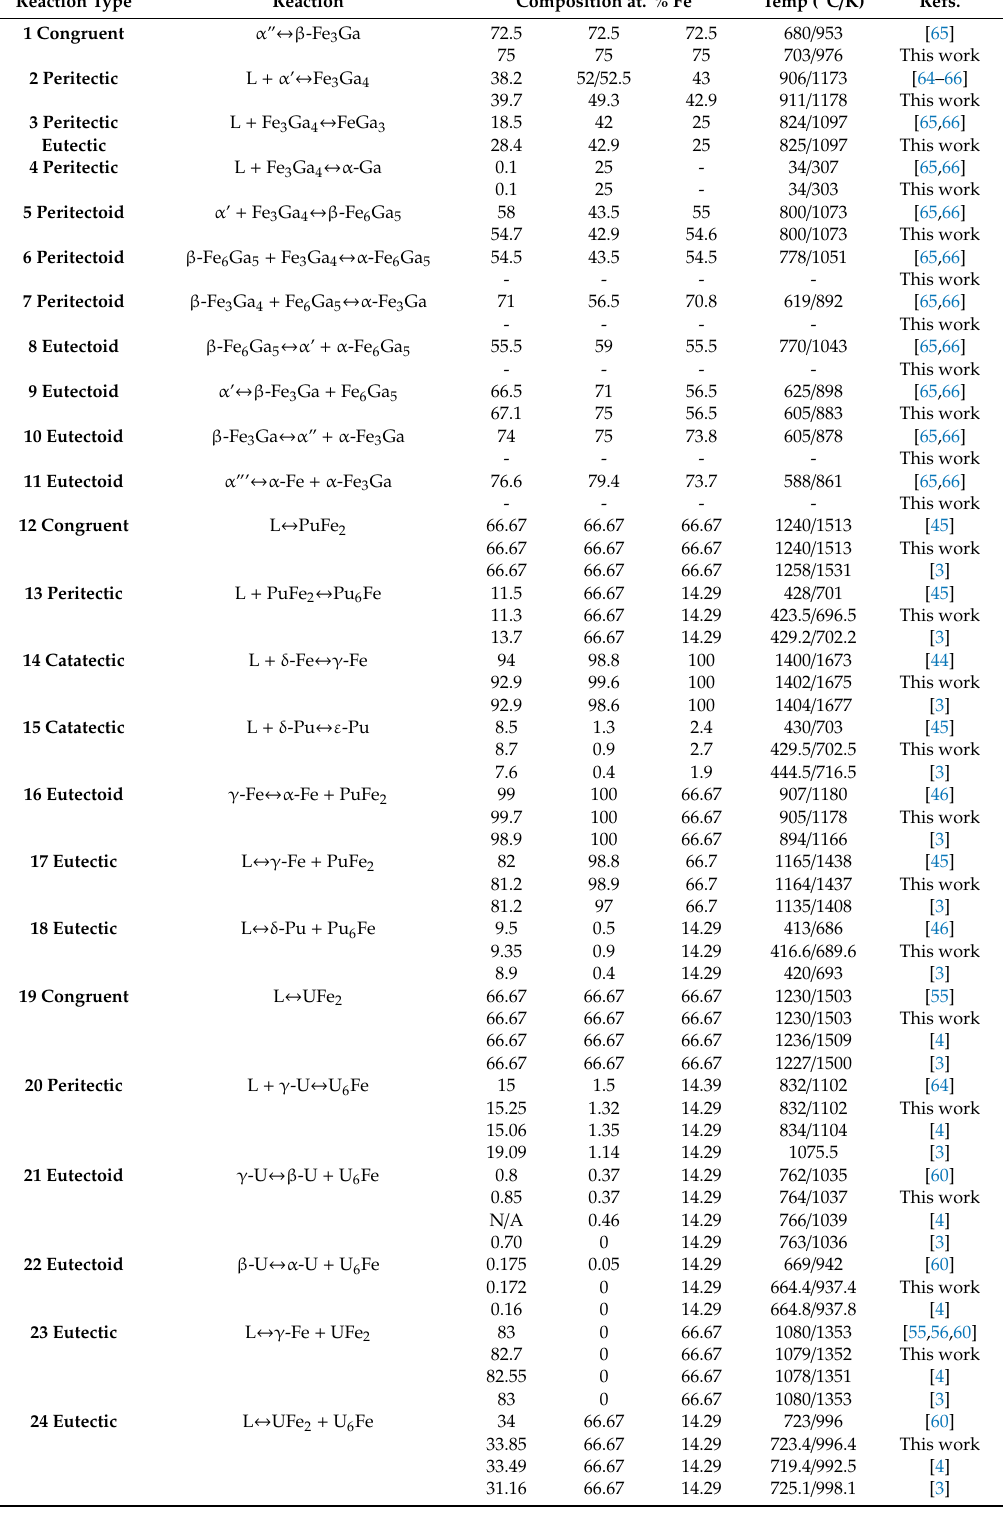
Table 5. Invariant reactions for Fe-Ga, Pu-Fe and U-Fe systems compared with experiments and models. Reaction Type Reaction Composition at. %